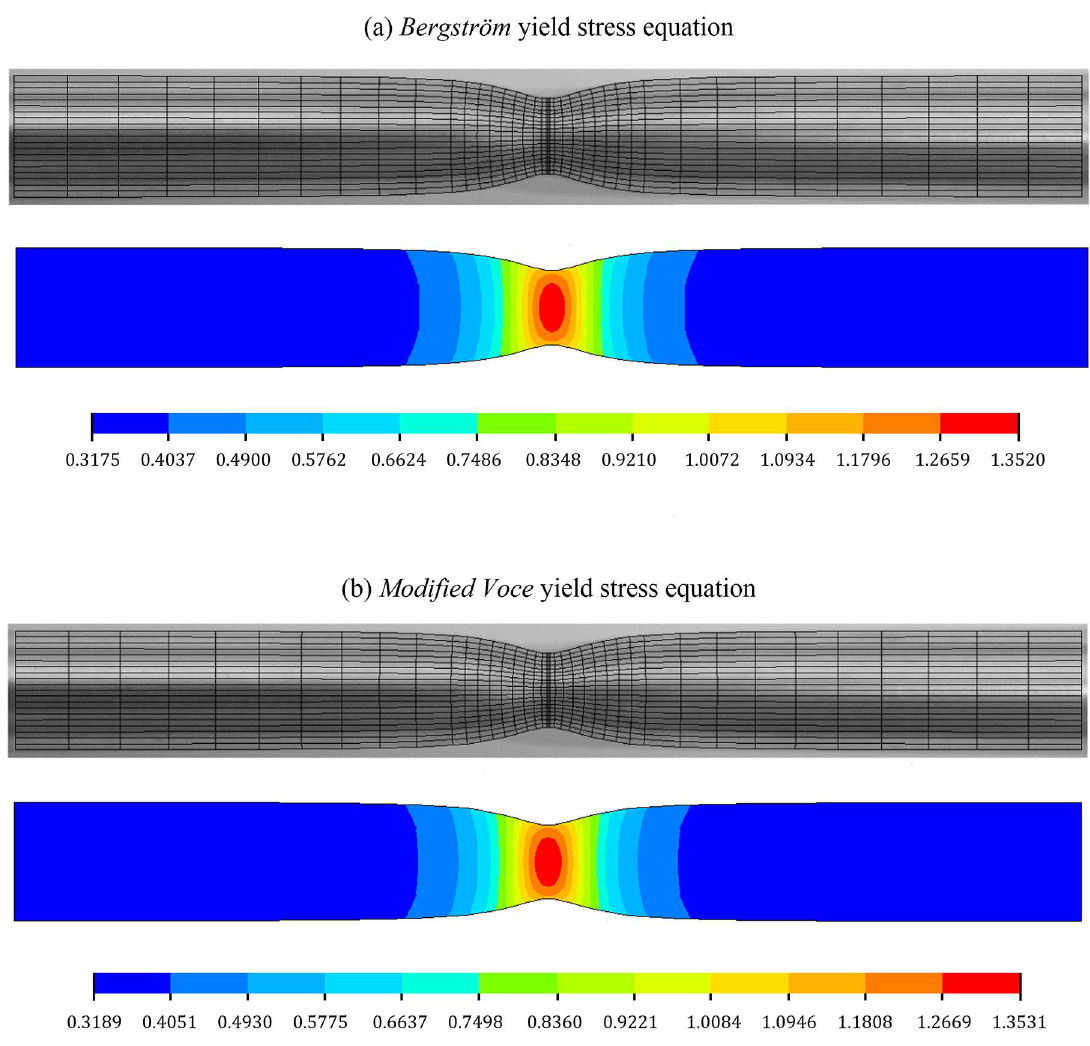
Figure 4. Finite element mesh and actual specimen at final stage of deformation and corresponding distribution of the equivalent plastic strain for (a) Bergström and (b) Modified Voce